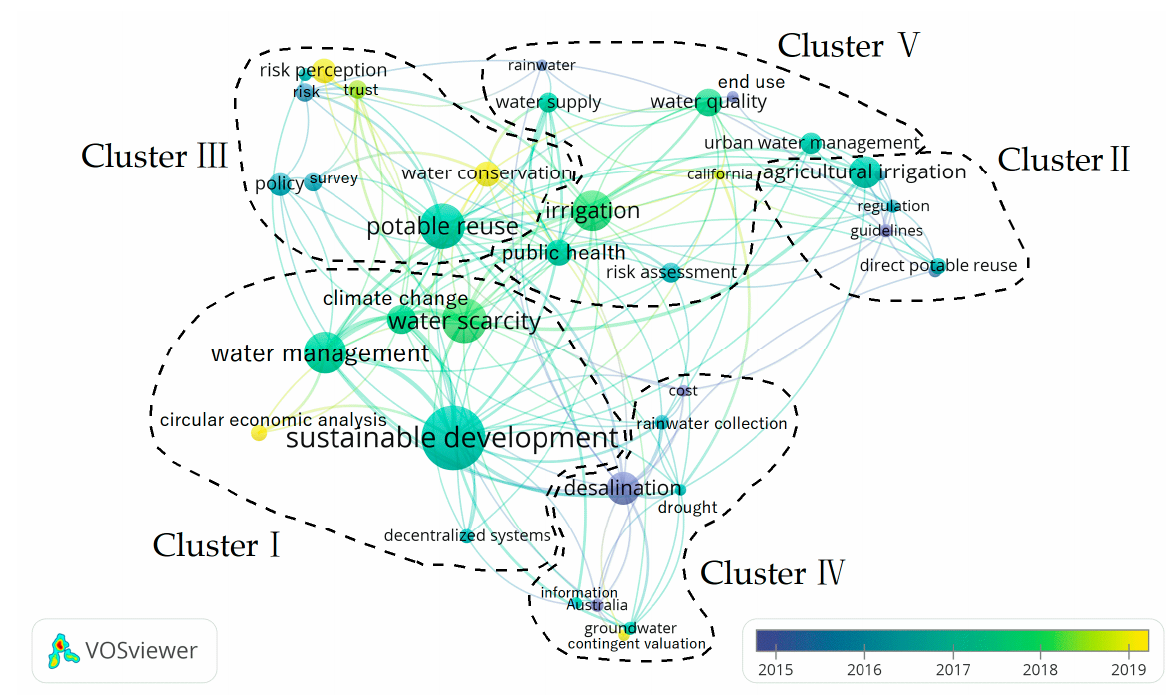
Figure 5. Keyword co-occurrence networks and clusters from 2011 to 2022.